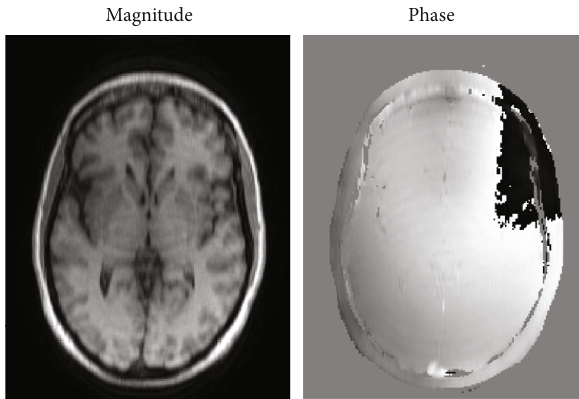
Figure 2: The magnitude and phase images in the initial step under the RSPe sampling pattern at 30% sampling rate on the brain dataset of Figure 1. Both images have